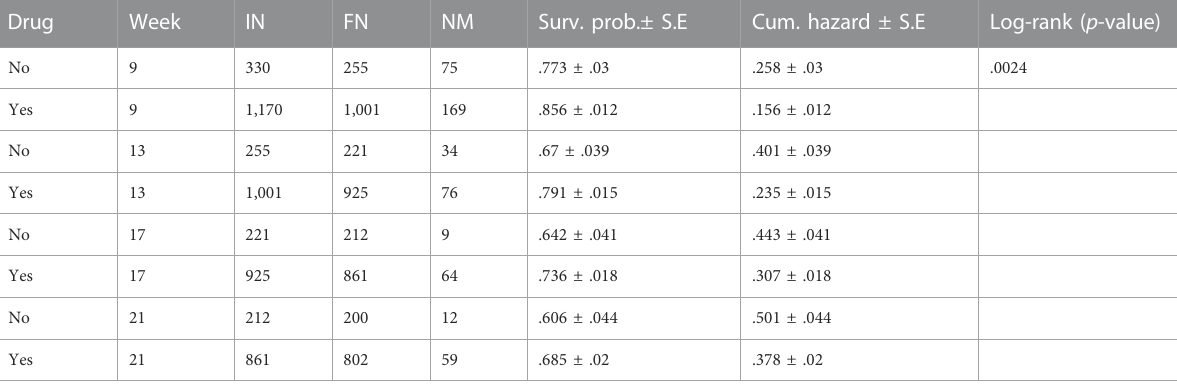
TABLE 6 Effect of antibiotics usage on survival performance of birds (5 – 21 weeks).